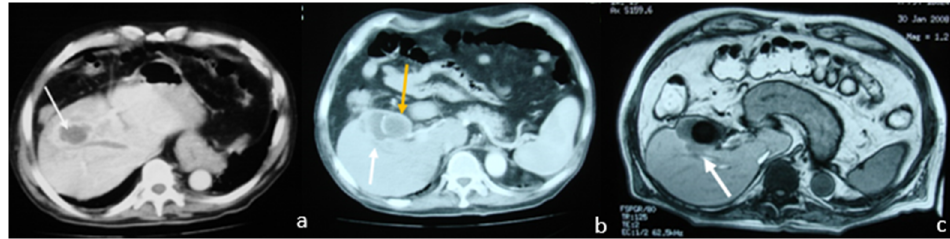
Figure 4. Contrast-enhanced Computed Tomography (CT) and MRI images which show overdistended and inflammatory gallbladder and a nodular lesion occupying the liver. ( a ) Contrast-enhanced CT: nonhomogeneous, hypodense mass located in the right lobe of the liver (white arrow); ( b ) contrast-enhanced CT: gallbladder with wall thickening and a large stone (yellow arrow) causing gallbladder neck obstruction (white arrow: liver abscess); ( c ) T1 out-of-phase axial MRI image: nodular lesion (white arrow) occupying the fourth and eighth liver segments in continuation with the overdistended and inflammatory gallbladder. It also revealed diffuse mural thickening with alternating layers of abnormal signal, as well as pericholecystic and perihepatic fluid.